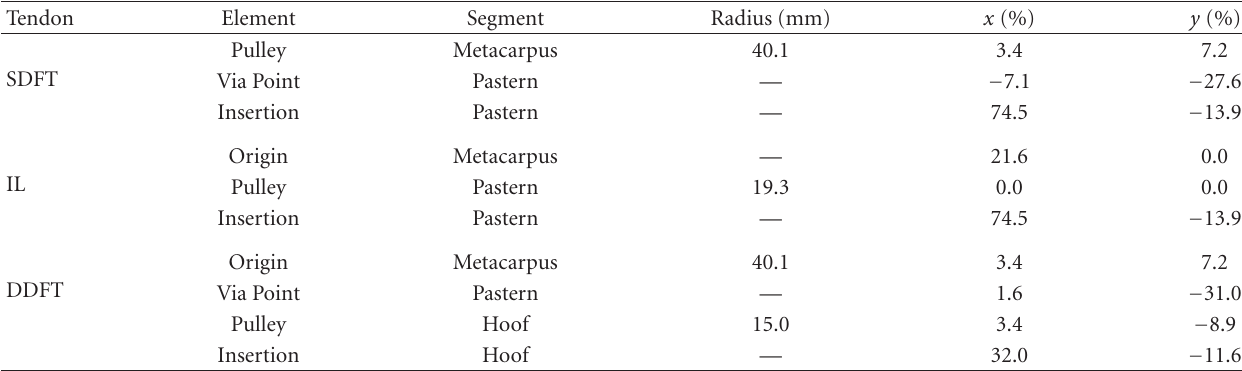
Table 1: Parameters for the distal forelimb model. The x axis is directed from the proximal joint of the given segment toward the distal joint and the y axis is directed cranially. x and y values, defining either the origin and insertion points of muscle-tendon paths, or the centers of pulleys and via points, are given as percentages of their respective segment